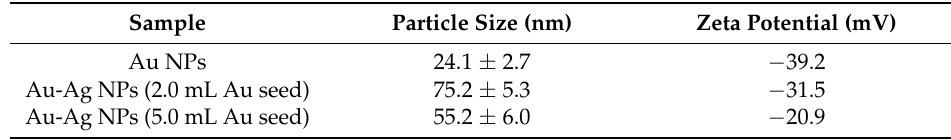
Table 1. Particle size and zeta potential for Au NPs and bimetallic Au-Ag